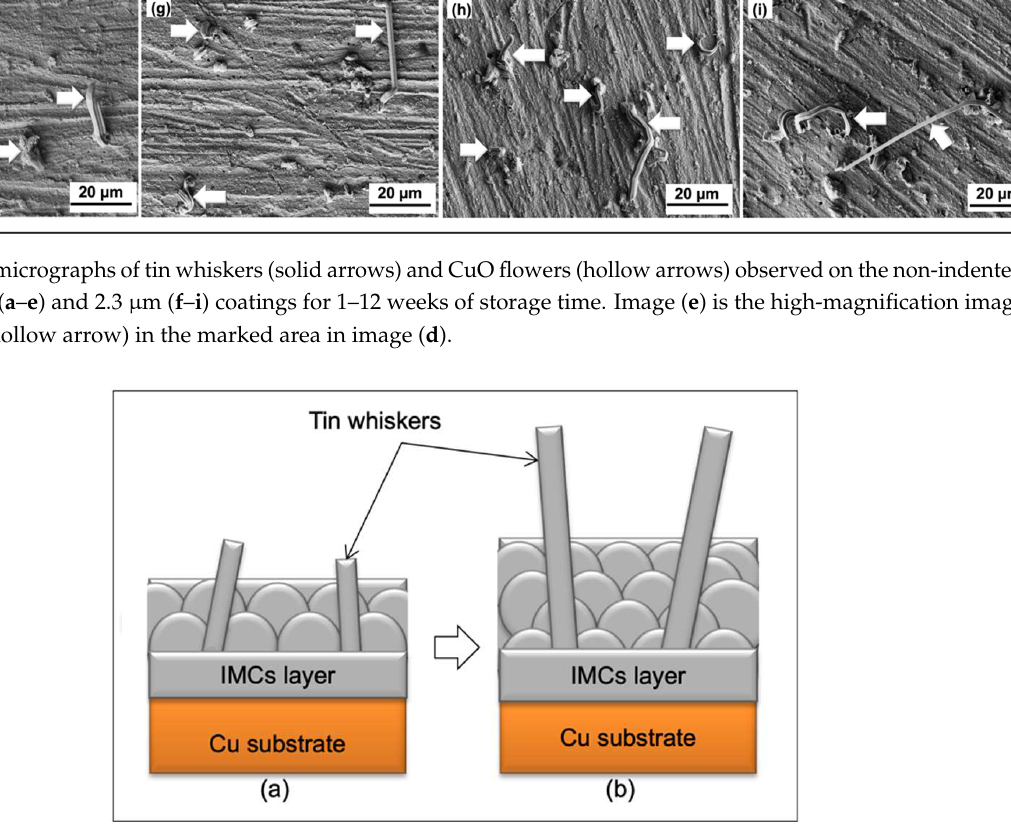
Figure 4. A schematic diagram of the whiskers’ formation on thin ( a ) and thick ( b ) tin coatings of immersion surface finish.